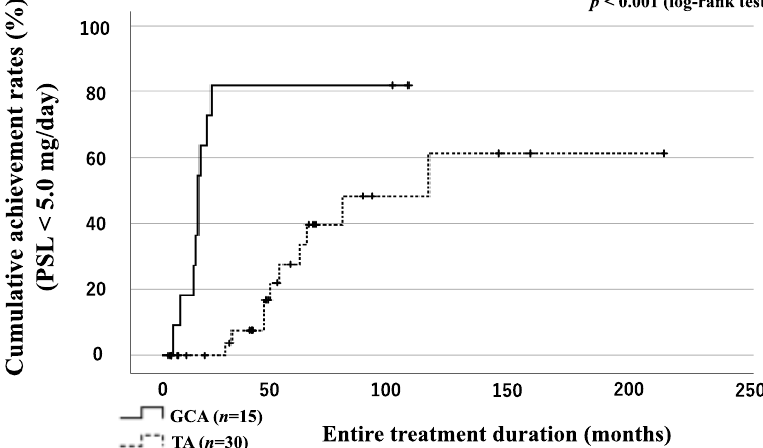
Figure 5. Rates of patients with GCA and TA achieving the tapered PSL dose (PSL < 5.0 mg/day). The proportions of patients achieving a tapered PSL dose (<5.0 mg/day) were compared between GCA and TA groups using Kaplan–Meier curves. The starting point (0 months) was the date of the the GCA and TA groups using Kaplan – Meier curves. The starting point (0 months) was the date of the initiation of remission induction therapy. A significant difference was observed between the and TA GCA and TA groups.